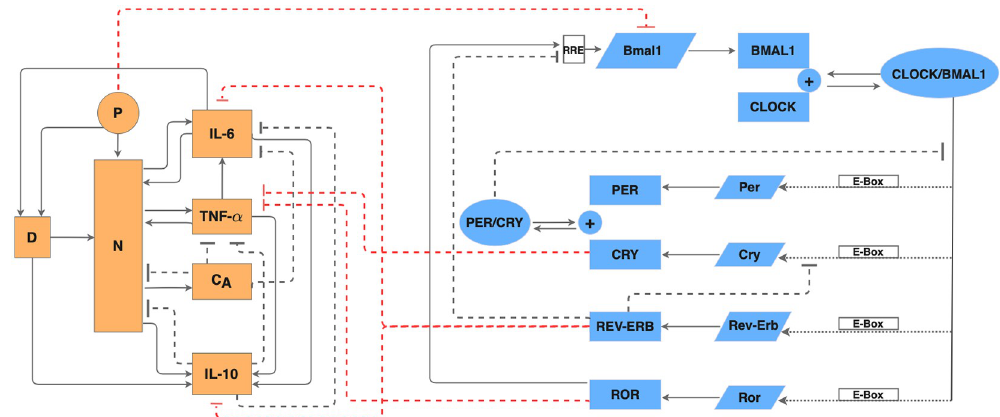
Fig 1. Regulatory network of the coupled immune system and circadian clock. Schematic diagram of the acute immune response model (orange shapes) and the circadian clock (blue shapes) in the lung of a rat. In the circadian clock model, slanted boxes denote mRNAs; blue rectangles denote proteins; ovals denote protein complexes. Dotted arrows represent transactivation; blunt dashed arrows represent inhibition. In the acute inflammation model, P denotes endotoxin; D , damage marker; N , activated phagocytic cells; C , slow-acting anti-inflammatory cytokines. A